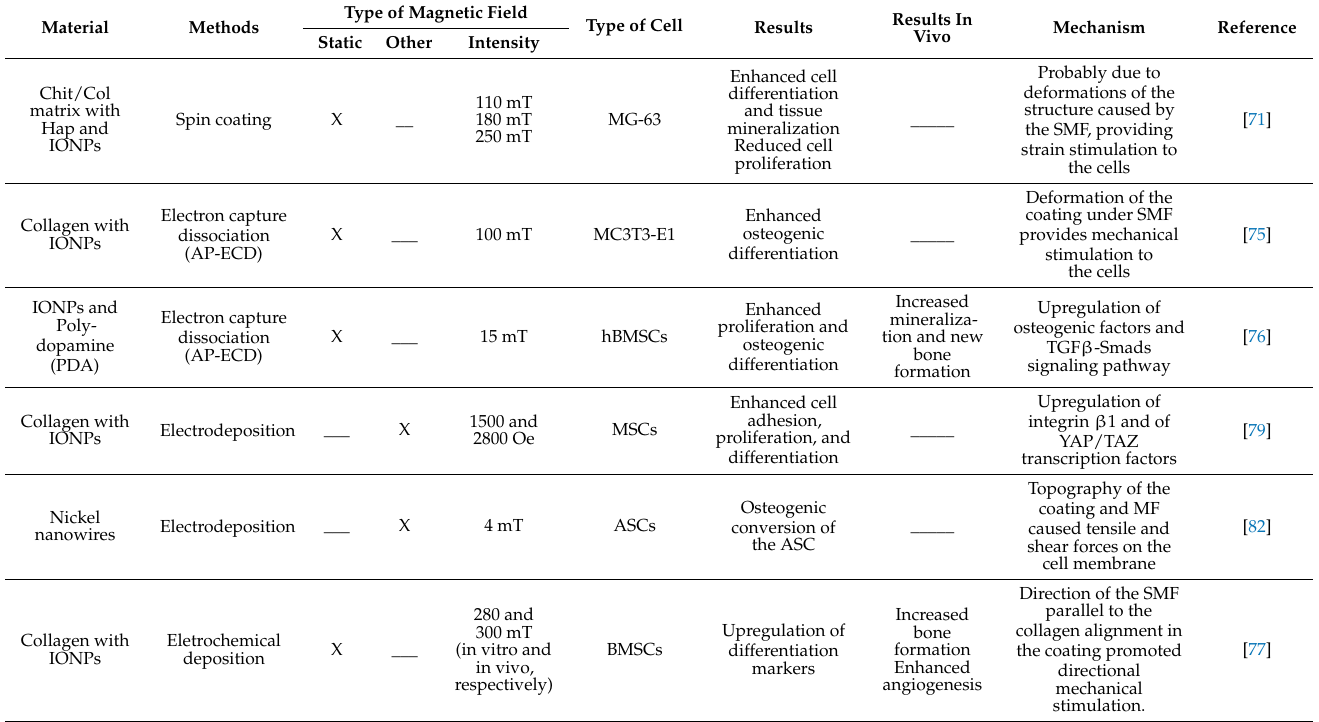
Table 4. Summary of studies reporting the influence of magnetic coatings on bone